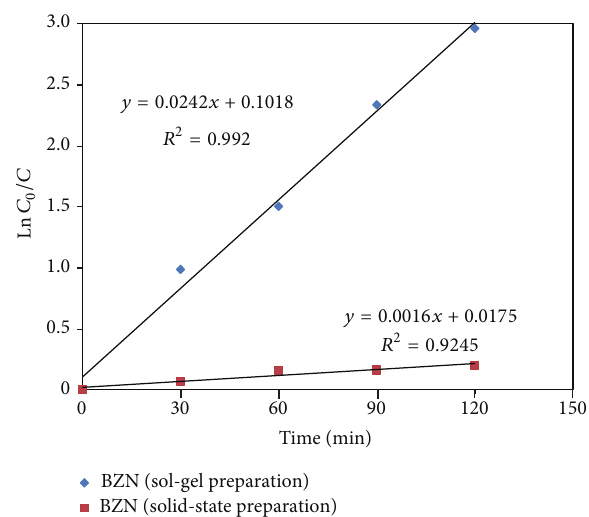
Figure 6: Reaction kinetics for the BZN catalysts prepared by different synthetic